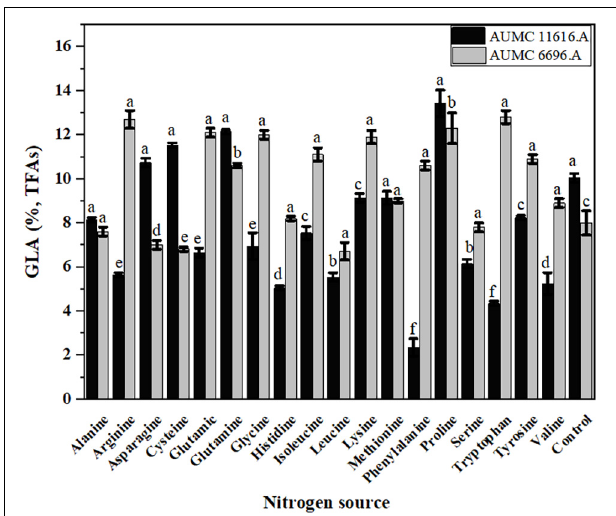
FIGURE 6 | Effect of different amino acids on the GLA content of TFAs in R. pusillus AUMC 11616.A and M. circinelloides AUMC 6696.A strains grown at 30 ◦ C for 4 days, on different nitrogen sources. Ammonium tartrate was employed as the control. Error bars represent the average standard deviation from three biological replicates. Values that show different superscripts were significantly different from each other using t -test ( p < 0.05).